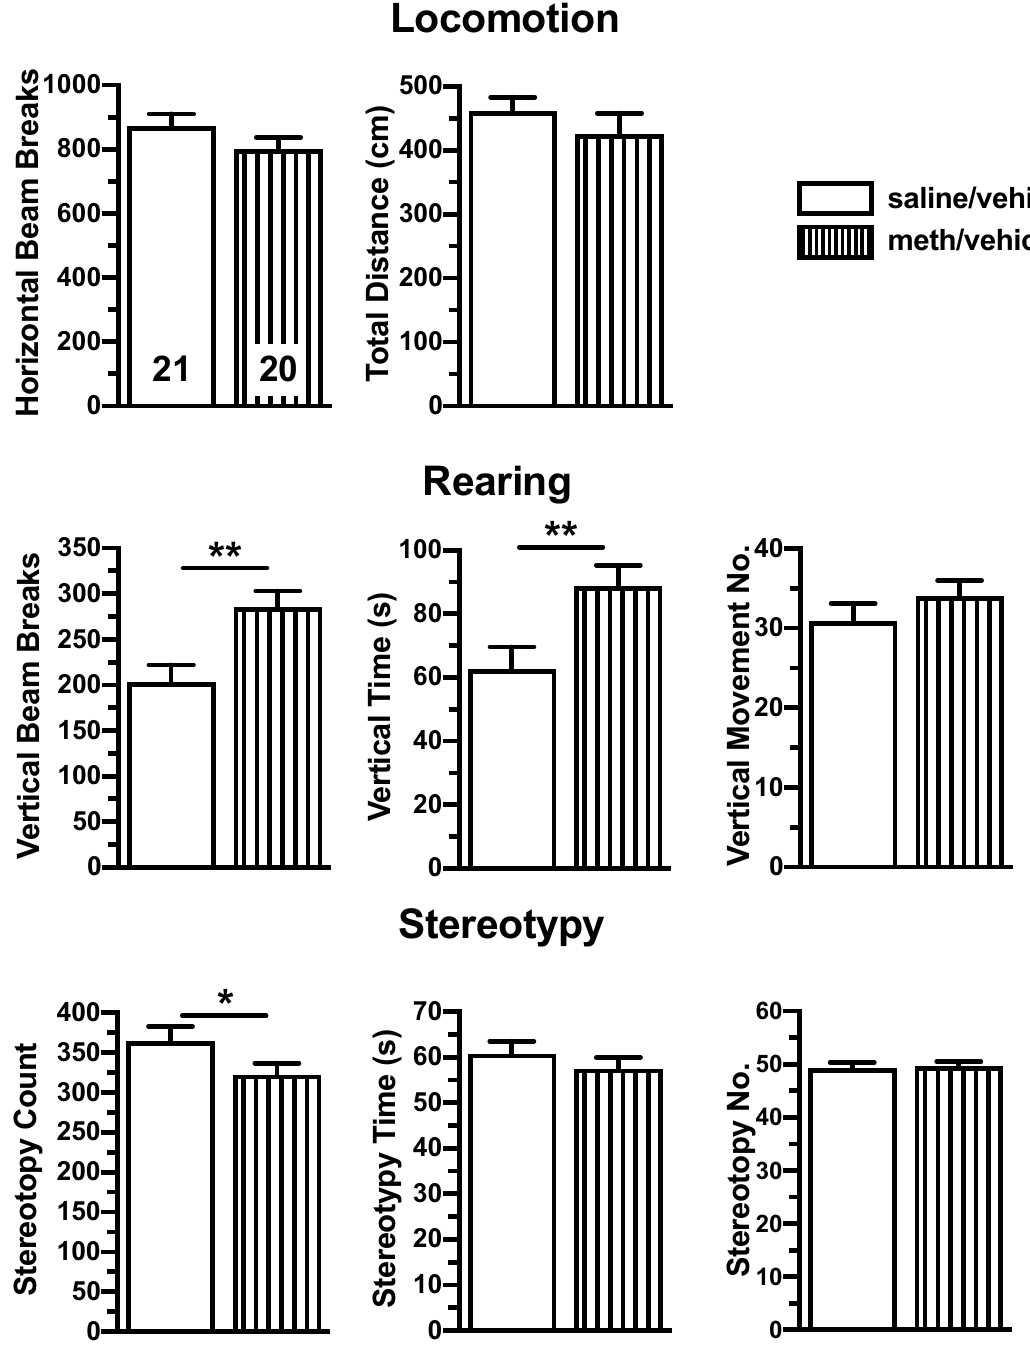
Figure 5. Onset of methamphetamine (meth)-induced behavioral sensitization. Meth/vehicle rats exhibited enhanced vertical outcomes (beam breaks and time) and reduced stereotypy count compared to saline/vehicle rats. One-tailed Student’s t-test, *p < 0.05, **p <